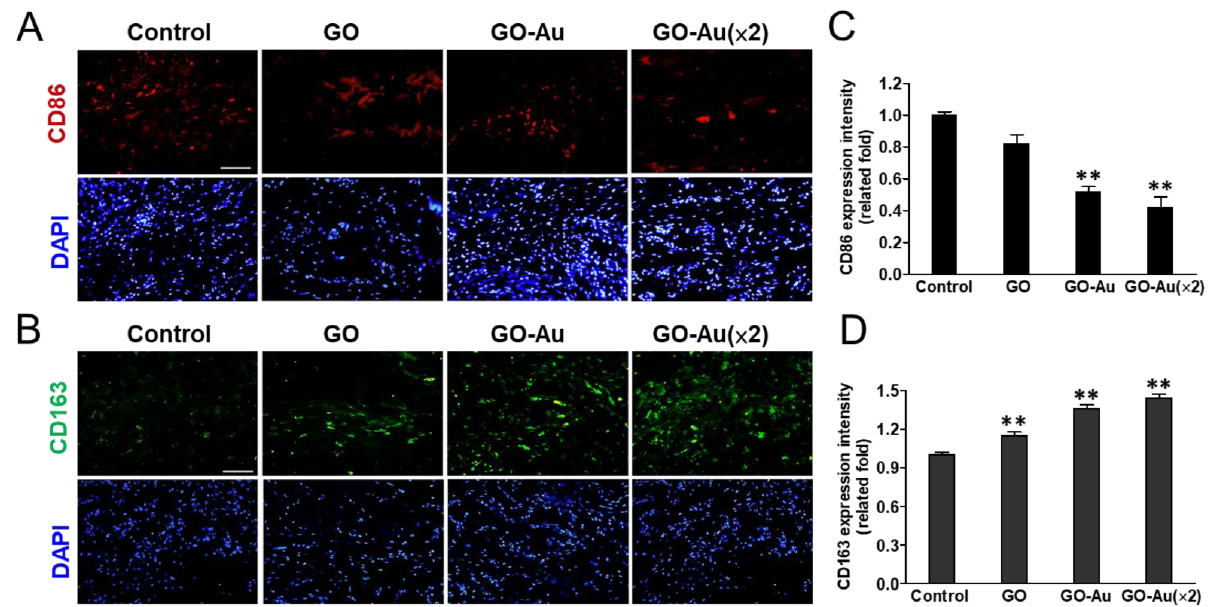
Figure 9. Immunohistochemical analysis of macrophage phenotype markers. Sections of explanted nanocomposites of GO, GO-Au, and GO-Au (×2) with surrounding tissue were stained for macrophage phenotype markers of ( A ) CD86 (M1) (red) and ( B ) CD163 (M2) (green). Cell nuclei were stained with DAPI (blue). Scale bar = 20 μ m. The fluorescence intensity of ( C ) CD86 and ( D ) CD163 were quantified and recorded. Data are shown as mean ± SD ( n = 6). ** p < 0.01 as compared with the control group.